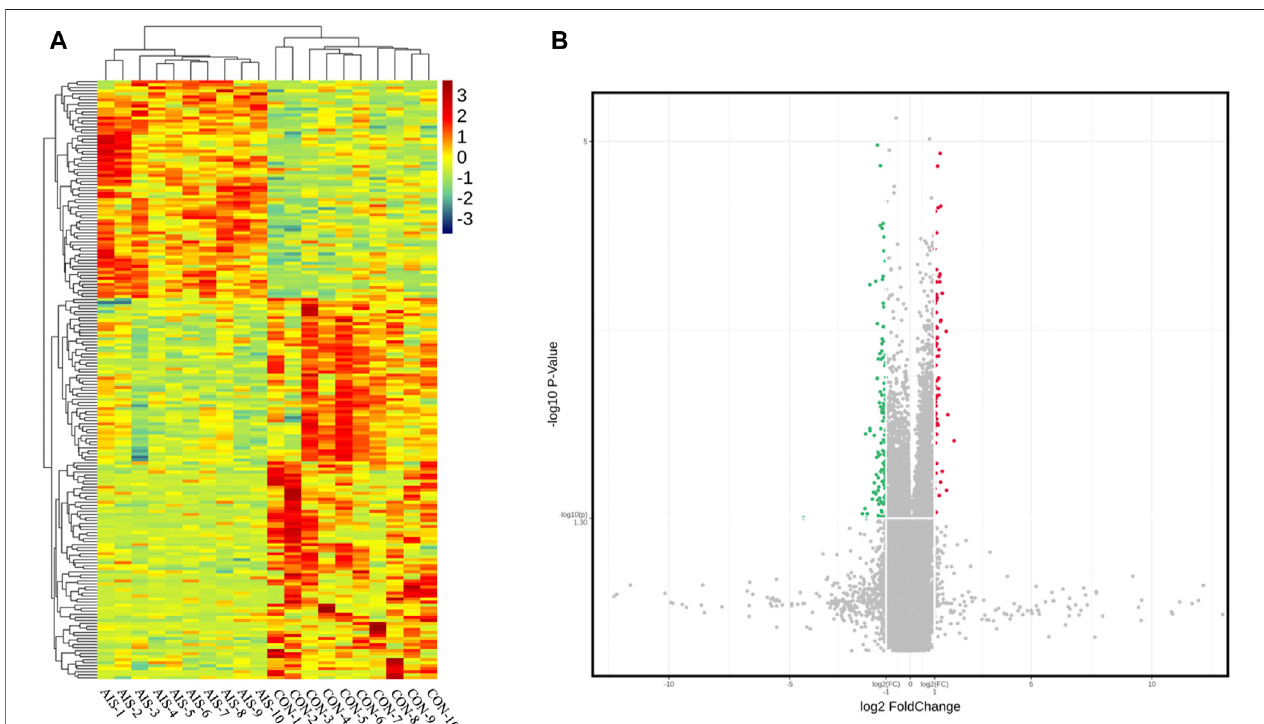
FIGURE 2 | CircRNA pro fi les of plasma exosomes from AIS patients (AIS) and controls (CON). (A) Heat map of circRNAs differentially quanti fi ed between AIS patientsandcontrols. (B) Volcano plotofcircRNA pro fi les betweenAISpatients and controls. Reddots represent signi fi cantlyupregulatedcircRNAs (log 2 foldchange ≥ 1.00 and p < 0.05, n = 10, independent two-sample t -test), and green dots represent signi fi cantly downregulated circRNAs (log 2 fold change ≤ − 1.00 and p < 0.05, n = 10, independent two-sample t